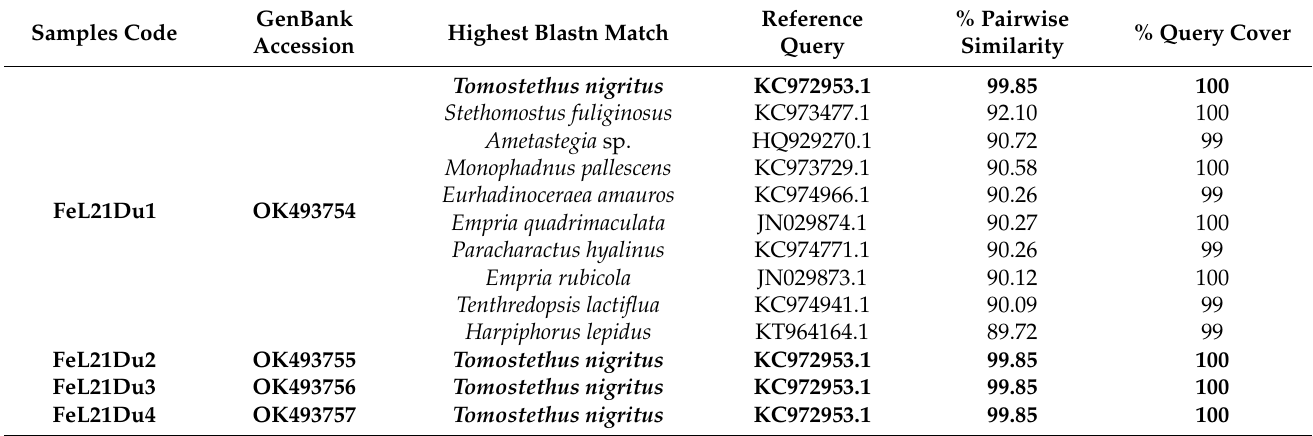
Table 1. Summary of nucleotide-nucleotide BLAST (BLASTn) results of samples obtained in this study (FeL21Du1–FeL21Du4) against the NCBI database. BLASTn matches in bold indicate the closest match between the GenBank Accession sequence and Reference Query sequence. BLASTn matches not highlighted in bold have less similarity between the GenBank Accession sequence and Reference Query